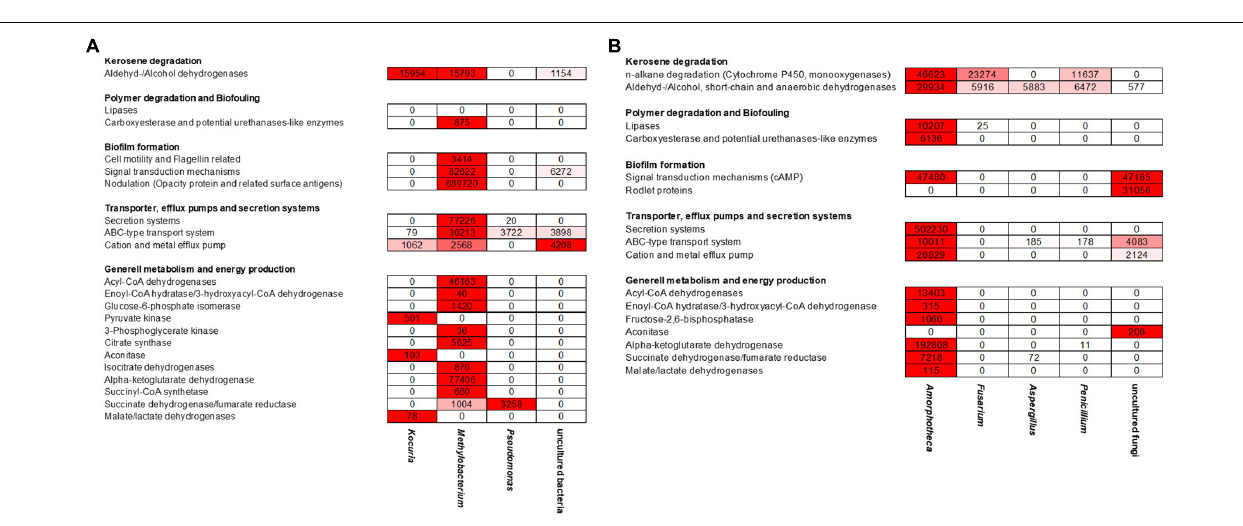
FIGURE 5 | Heat map reflecting the expression of genes affiliated with kerosene and polymer degradation, biofilm formation, transport and secretion systems, and general metabolism and energy production mechanisms of the individual (A) bacterial and (B) fungi-related reads; color key: high expression level, low expression